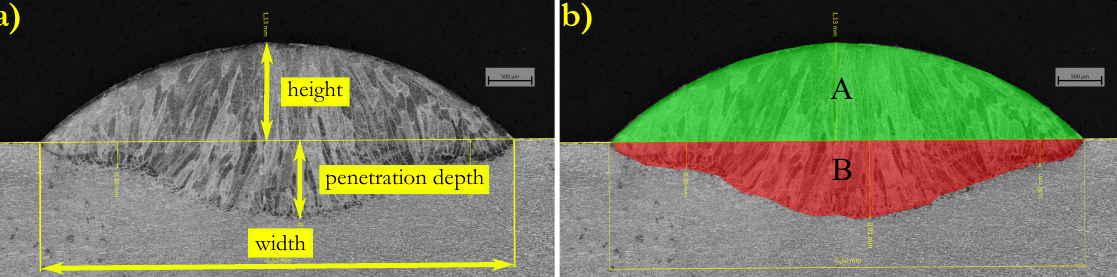
Figure 3. The features of the single bead geometry: ( a ) height, width and penetration depth, ( b ) added material (A) and penetration area